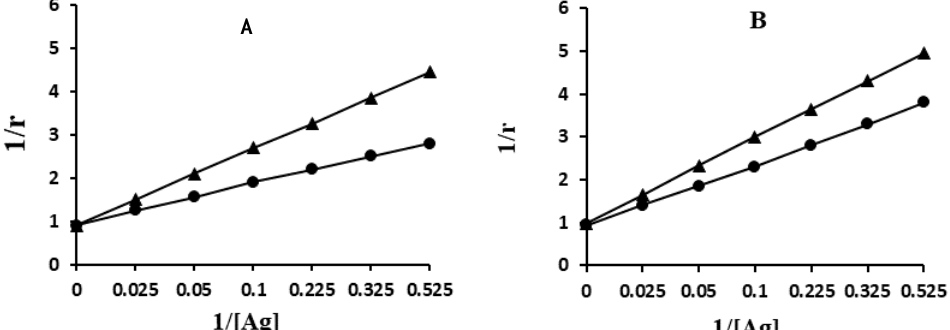
Figure 4. Determination of antigen-antibody binding affinity and apparent association constant by Langmuir plot. Antigen used in this assay were Gly-HSA. Immune complexes were prepared by incubating 100 µg of IgG from IV-S (-●-) and IV (- ▲ -) subjects ( A ) and IgG from III-S (-●-) and III (- ▲ -) subjects ( B ) with varying amount of antigen (0–100 mg) in an assay volume of 100 µL for 2 h at room temperature and overnight at 4°C.